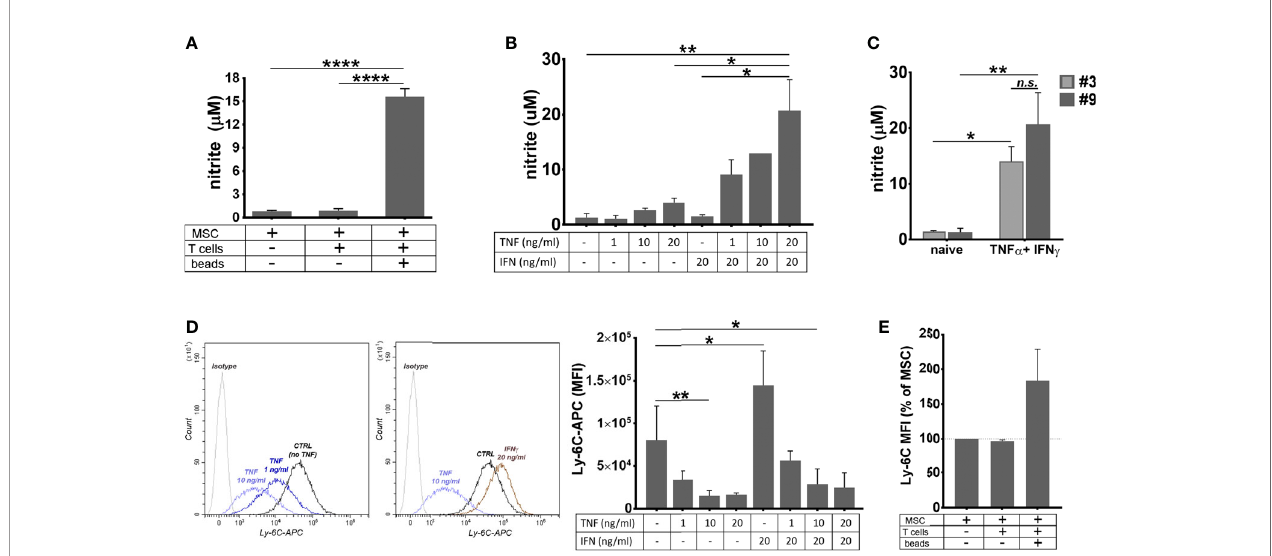
FIGURE 5 | The behavior of MSC in pro-in fl ammatory conditions. (A) The level of nitrite secreted by MSC in basal conditions, and in the co-culture with resting or proliferating T cells. The values represent mean+/- S.D. @ of two independent experiments performed in triplicates. (B) The levels of nitrite secreted by MSC after 48 hours of culture in the presence of TNF a and IFN g . Note the synergic effect of the two cytokines on the secreted NO level. The values represent mean +/S.D of four experiments performed in duplicates with different MSC batches at passages 7- 10. (C) The levels of nitrite secreted by cell culture at low and high passages. The values represent mean +/S.D of at least two experiments performed in duplicates. (D) The attenuation of Ly-6C expression on MSC after stimulation with TNF a in the presence or absence of IFN g . Note that, while TNF a produced a dose-dependent decrease in the expression of Ly-6C in MSC culture, IFN g had an inverse effect, however in the presence of both cytokines, MSC decrease Ly-6C expression. The values represent the mean +/- S.D. from the three independent experiments. Representative histograms showing Ly-6C expression in MSC with and without cytokines are also given. (E) Ly-6C expression on MSC in basal conditions, and in the co-culture with resting or proliferating T cells (n= 2 experiments). *p < 0.05, **p < 0.01, ****p < 0.001, n.s., not-signi fi